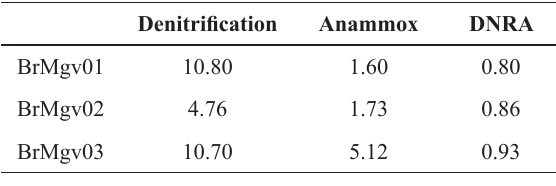
Normalized number of sequences affiliated to distinct transformations of nitrogen, found in the mangrove soil metagenomes. Values represent number of sequences in each 10,000 sequences of metagenomes.